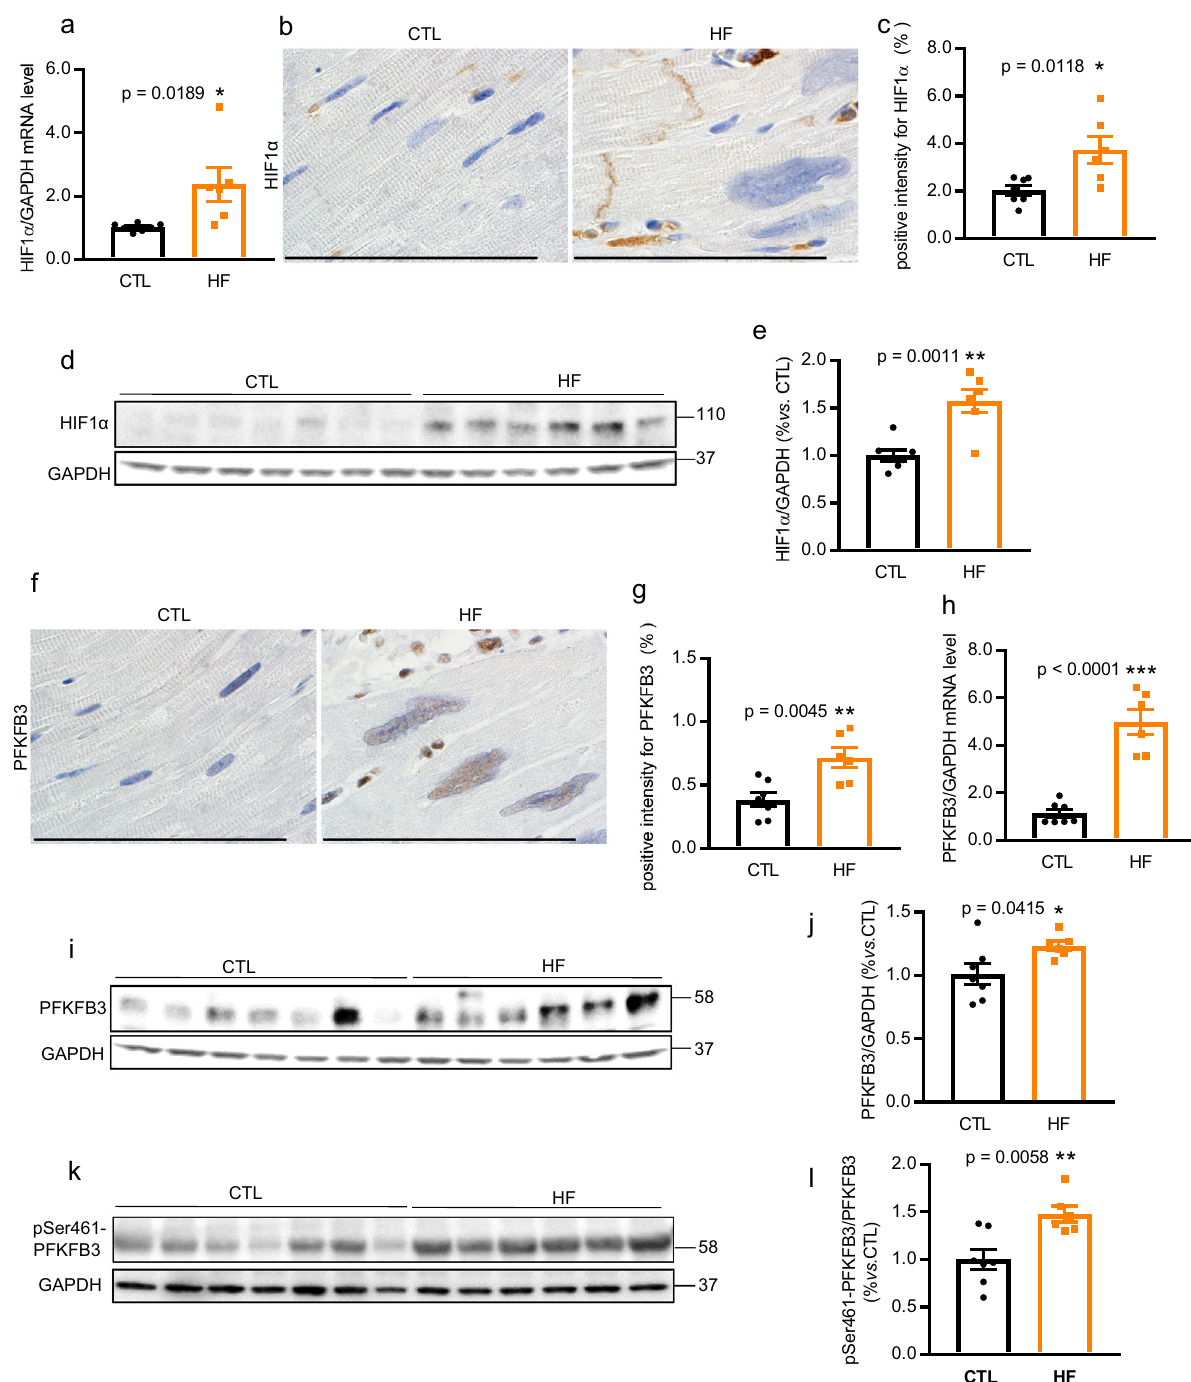
Fig. 4 Activation of HIF1 α , PFKFB3, and PFKFB3 phosphorylation at Ser461 in the myocardium of NHPs with HF. Expression of HIF1 α ( a – e ), PFKFB3 ( f